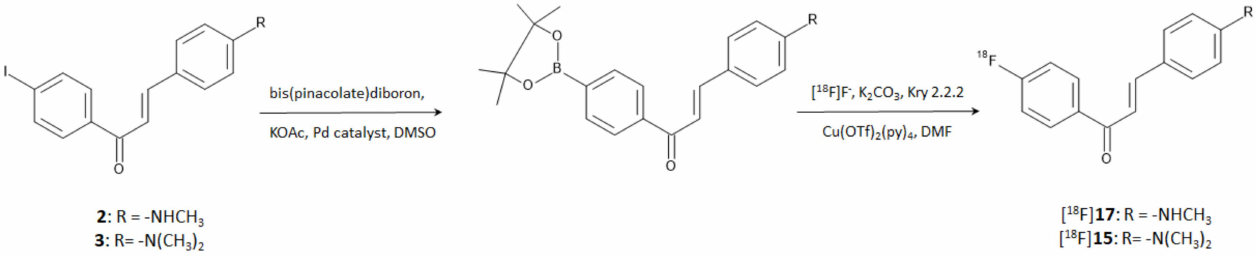
Figure 6. Reaction steps for the direct [ 18 F]-fluorination of a chalcone aromatic ring starting from the iodinated